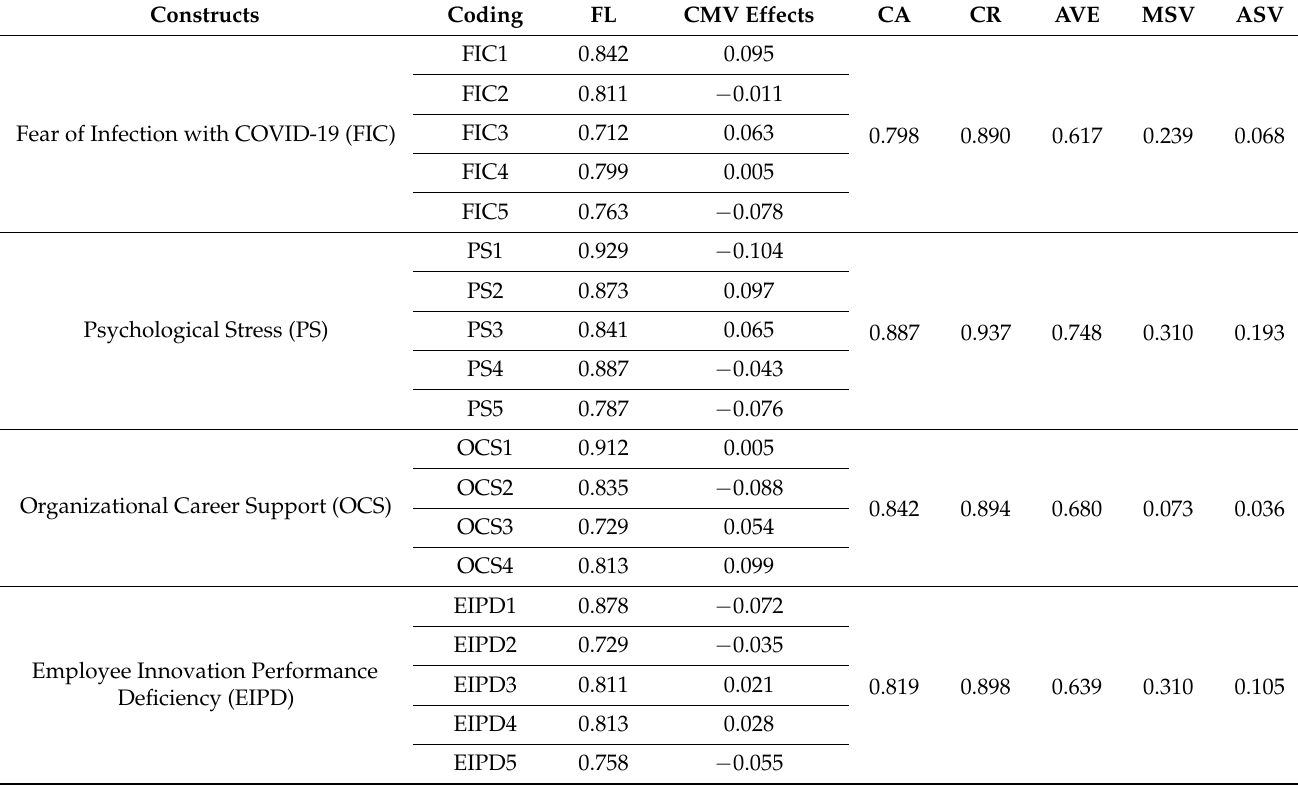
Table 4. The reliability and validity analysis of the measured